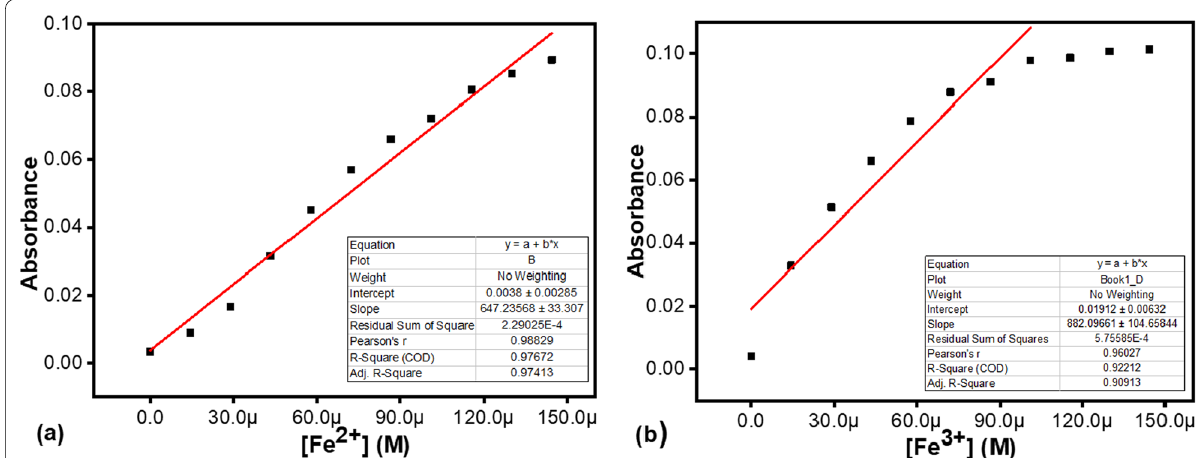
Fig. 4 The detection limit (via 3 σ /slope) of T. chebula extract with ( a ) Fe 2 + and ( b ) Fe 3 + (fitting up to x basis of UV–Vis titrations. σ means the average of the standard deviations